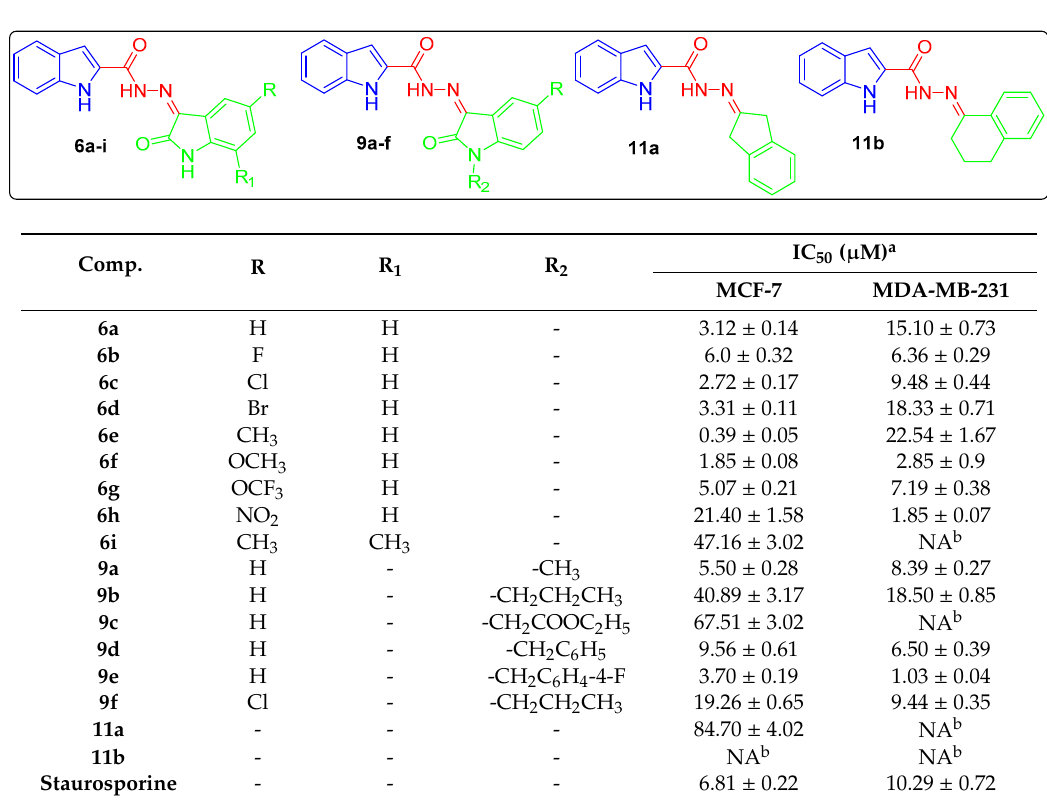
Table 1. Anti-proliferative activities for hybrids 6a–i , 9a–f , and 11a , b against MCF-7 and MDA-MB-231 breast cancer cell lines.